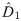
Distance contrast D^1 between the preferential attachment and the uncorrelated random graph model (null model).